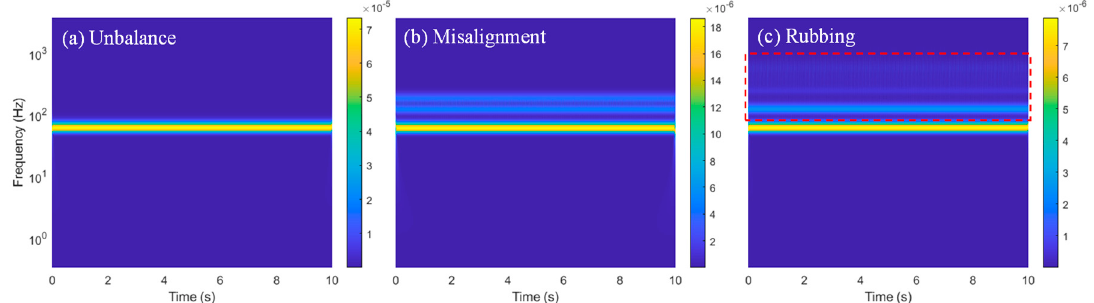
Figure 5. Sample unbalance, misalignment, and rubbing scalograms in the simulation model at a steady state of 3660 rpm with y -axis on a logarithmic scale; ( a ) Unbalance; ( b ) Misalignment; ( c ) Rubbing.